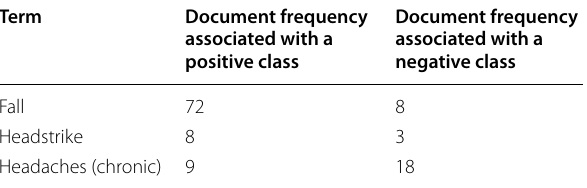
Table 3 Document frequency of terms associated with